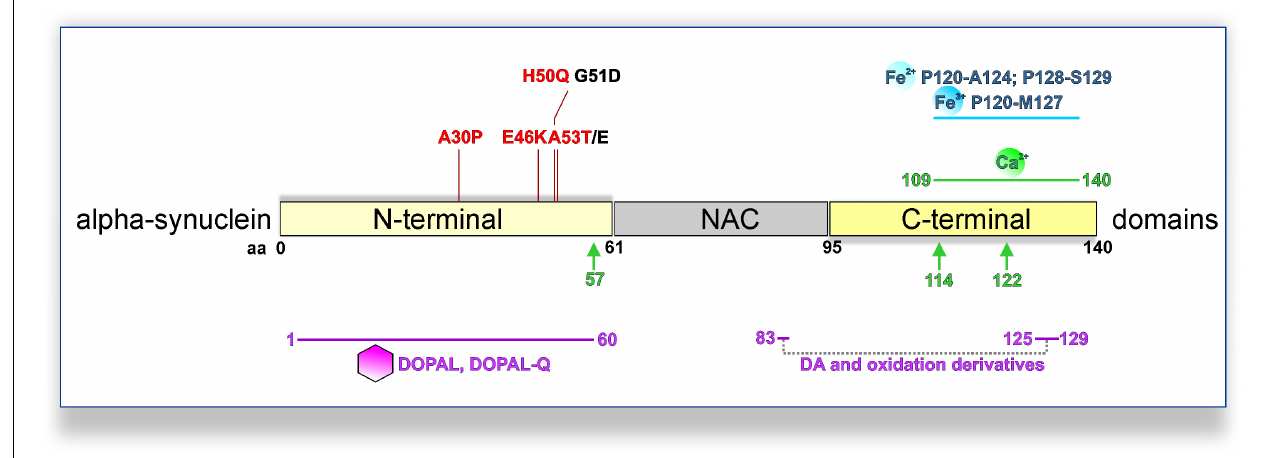
FIGURE 1 | PD-linked SNCA mutations and interactions with DA metabolites, calcium, or iron promoting pathological aSyn oligomerization and/or aggregation. PD-linked SNCA missense mutations that increase the oligomerization and/or fibrillization of aSyn in vitro are shown in red (otherwise black). DA and oxidation derivatives bind non-specifically to the C-terminus (aa 125–129), further stabilized by long-range electrostatic interactions with E83 of the NAC region (intermittent gray line). Also, DOPAL/DOPAL-Q adducts with N-terminal aSyn lysines are formed at the 1–60 domains (purple line). Fe 2 + (ferrous) and Fe 3 + (ferric) iron bind to adjacent regions at the C-terminus of aSyn (blue line; Fe 2 + : aa P120-A124 and P128-S129; Fe 3 + : aa P120-M127). Moreover, a calcium-binding motif has been mapped to the C-terminus of aSyn (green line; aa 109–140). Calcium also promotes calpain I-mediated cleavage of aSyn, with three major cleavage sites depicted (green arrows; monomeric aSyn: after aa 57; fibrillar aSyn: after aa 114 and